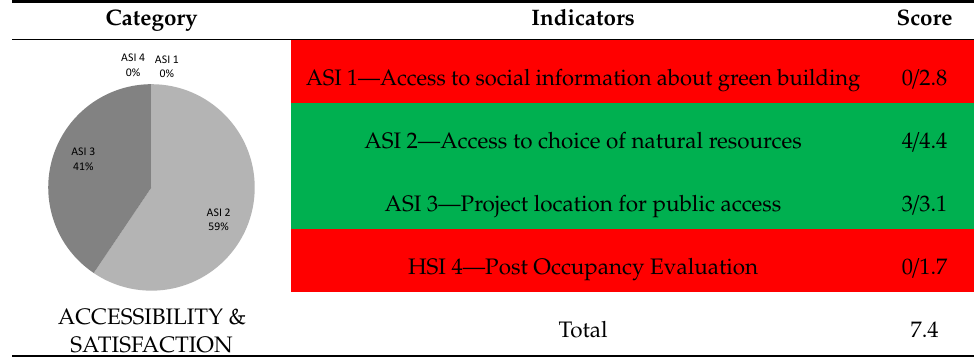
Table 14. RAG rating of Cultural Value Indicator in